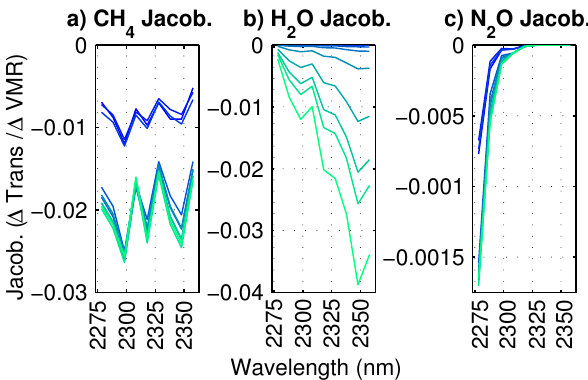
Fig. 4. (a) CH 4 Jacobian for each of the 10 atmospheric layers with colors transitioning from dark blue at the highest layer (layer 1) to light green for the lowest layer (layer 10). The CH 4 Jacobians with smaller magnitudes (dark blue) are for layers above the flight altitude. The same color scheme is used for the H 2 O Jacobians (b) and N 2 O Jacobians (c)